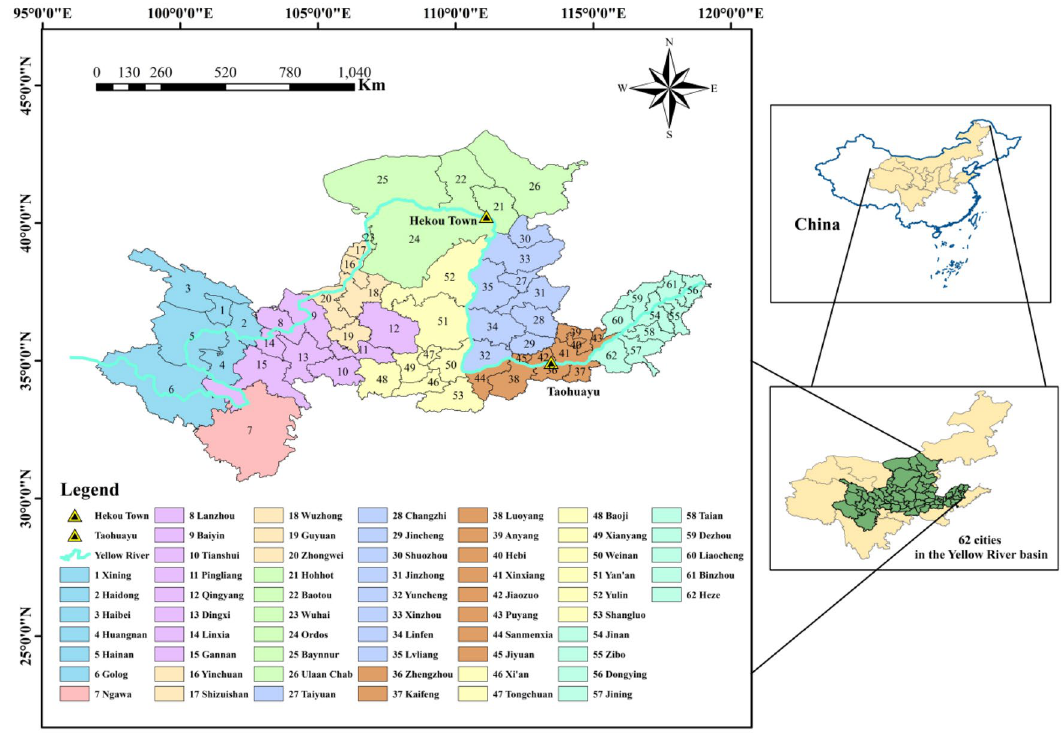
Figure 2. Geographical map of 62 cities in the Yellow River Basin. Note This was created by ArcMap-GIS, version 10.5. https:// www. esri.